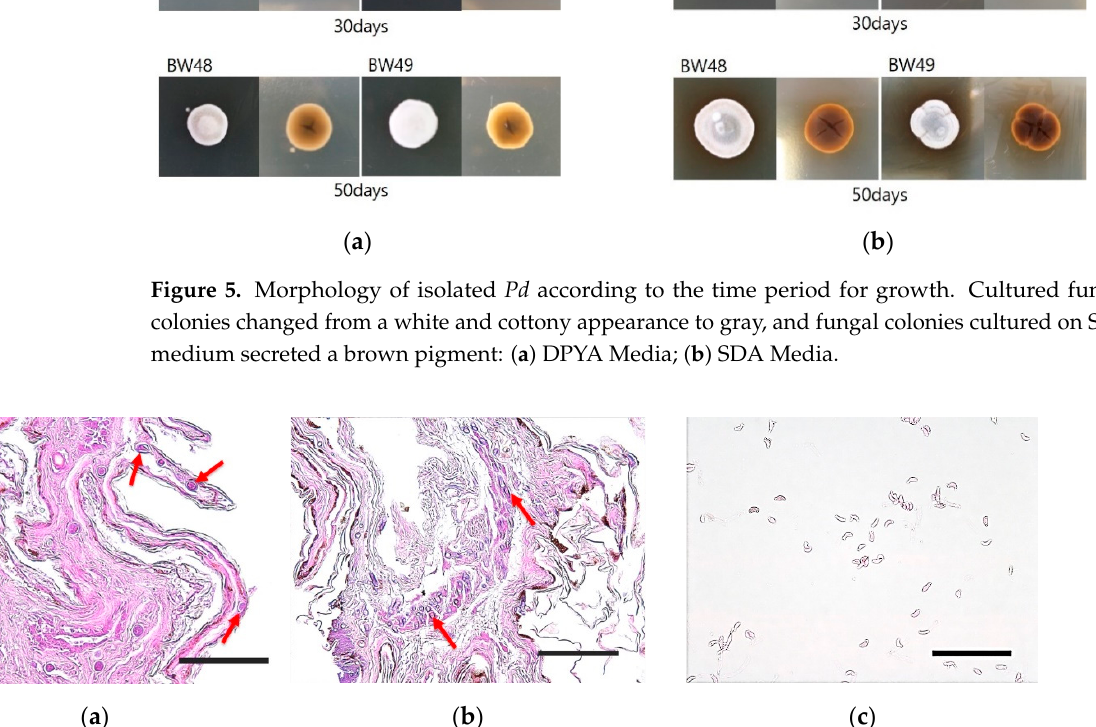
Figure 5. Morphology of isolated Pd according to the time period for growth. Cultured fungal colo- nies changed from a white and cottony appearance to gray, and fungal colonies cultured on SDA medium secreted a brown pigment: ( a ) DPYA Media; ( b ) SDA Media.